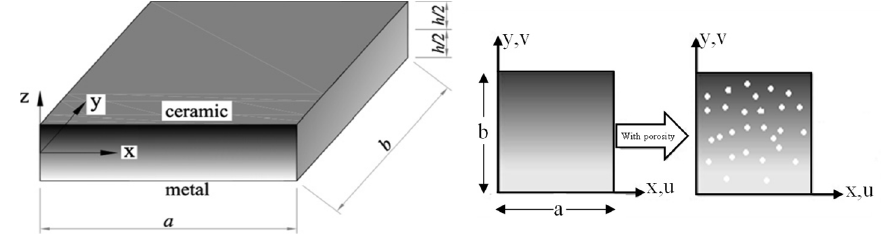
Figure 1. The geometric configuration of the functionally graded (FG) porous plate.